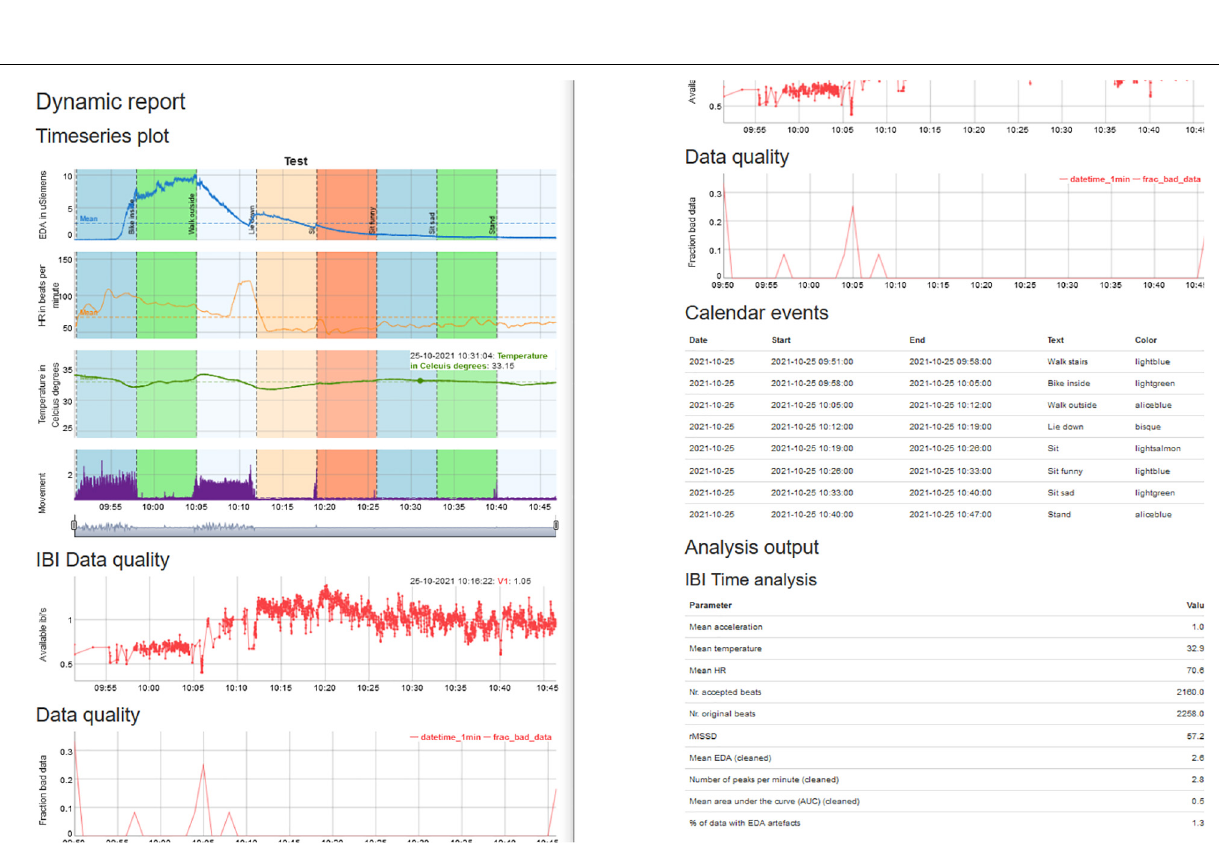
FIGURE 8 | Summary report of the analysis that can be read with your local